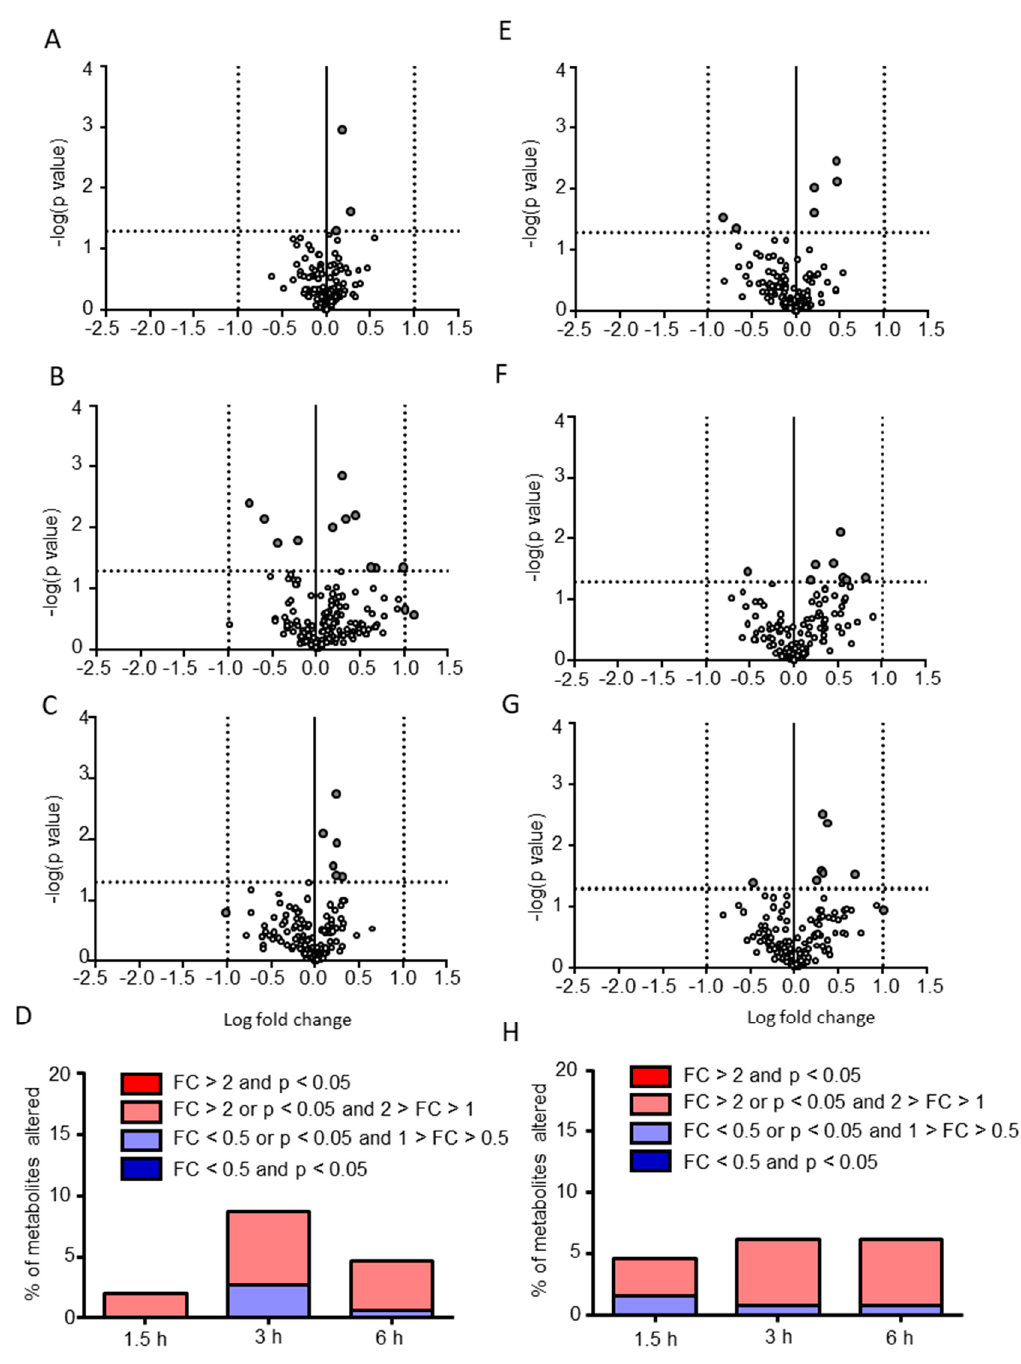
Figure 3. Putative hydrophilic metabolites altered by postprandial effects. Volcano plots ( A – C and E – G ) comparing the hydrophilic metabolites obtained from preprandial and postprandial subjects are shown. The postprandial periods were 1.5 h ( A and E ), 3 h ( B and F ), and 6 h ( C and G ) and the sample sources were CSF ( A – C ) and plasma ( E – G ). The p -values and fold changes (FCs) are plotted as -log10 and log2 values, respectively. Each dot indicates each hydrophilic metabolite. The threshold values ( p < 0.05 or fold change > 2) are indicated by dotted lines. The percentage of putative hydrophilic metabolites in CSF ( D ) and plasma ( H ) are also demonstrated.